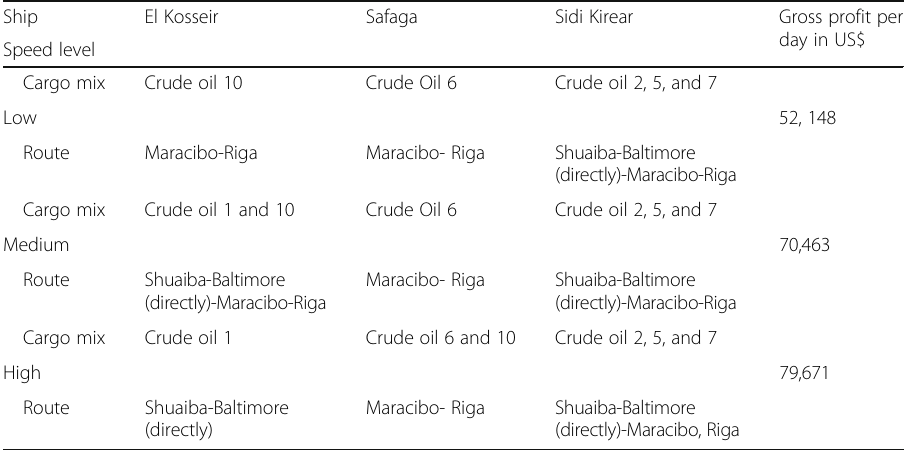
Table 6 Cargo mix, route, and gross-profit-per-day reported by the model (with gross profit per day objective) for each ship, classified by speed level